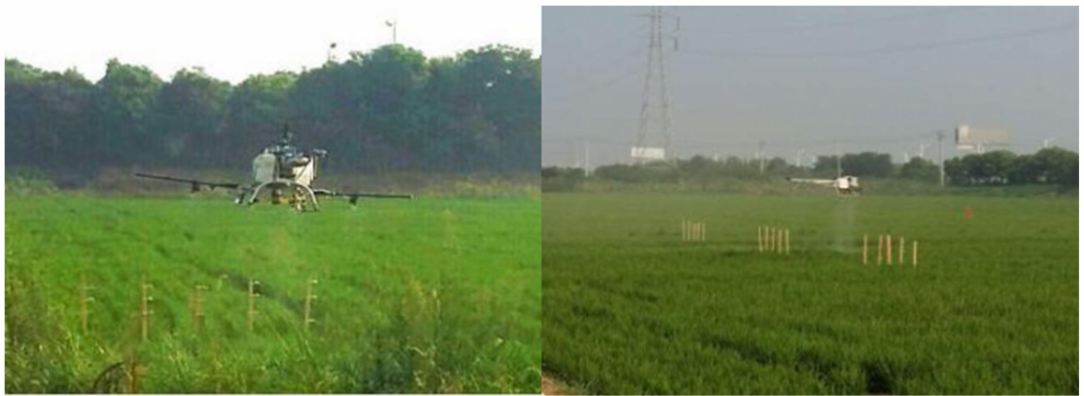
Figure 3. UAV paddy field spraying operations [35].